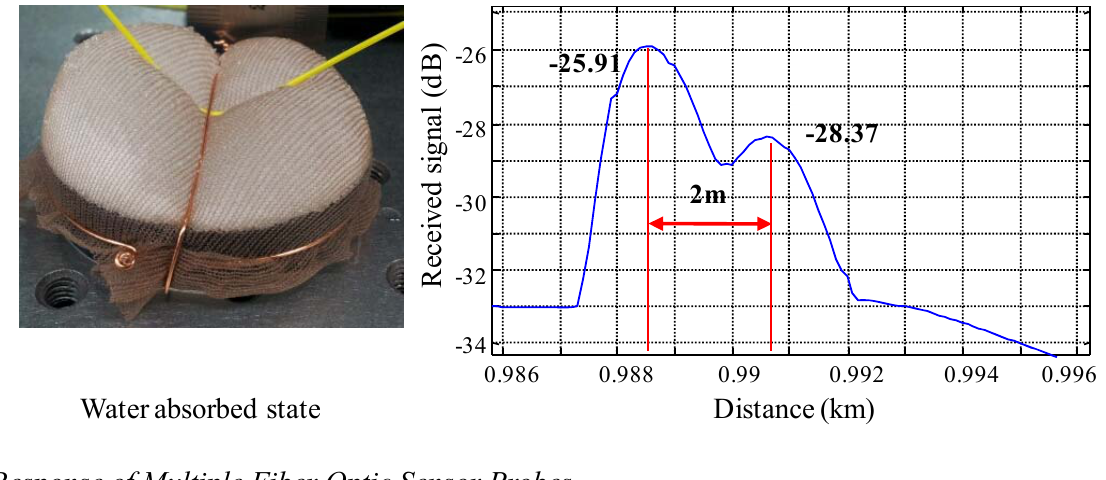
Figure 8. Absorbed state and received signal of a sensor